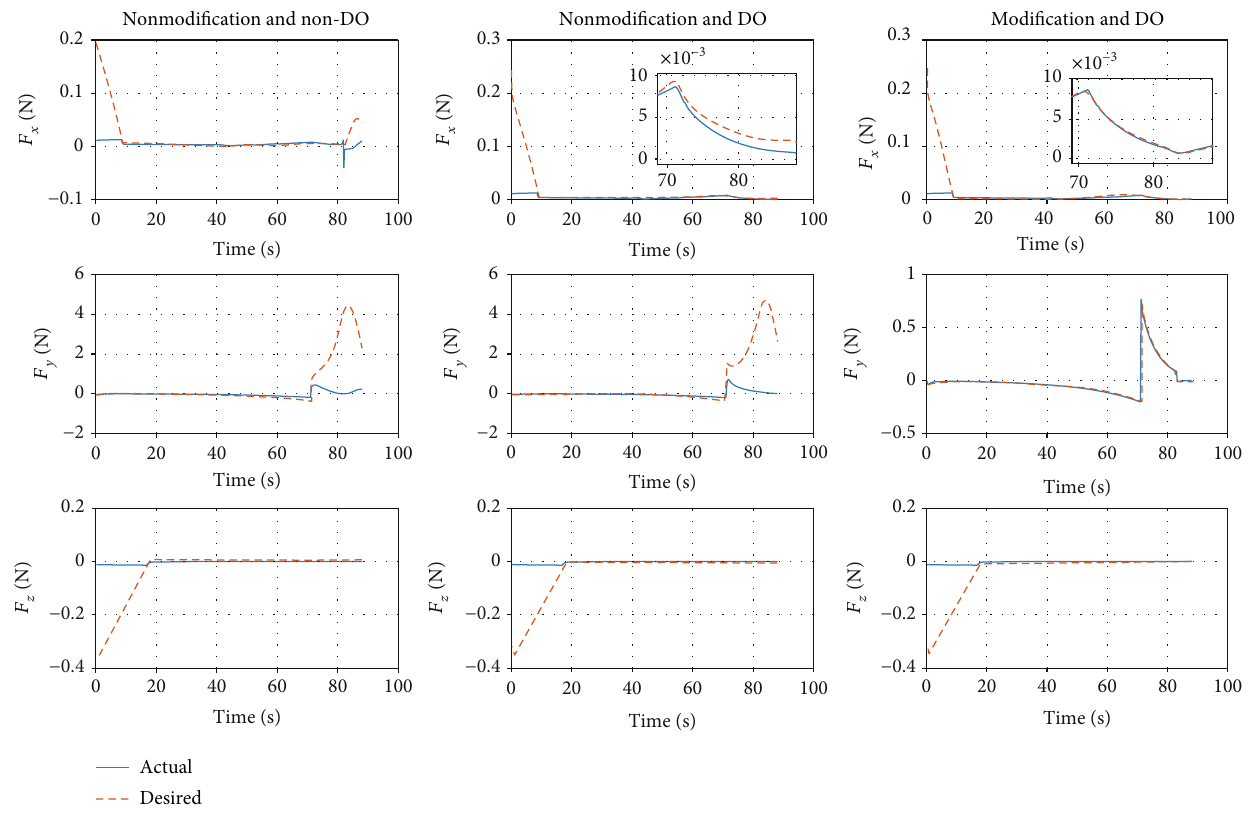
Figure 15: Comparisons of the desired control forces and actual control forces.